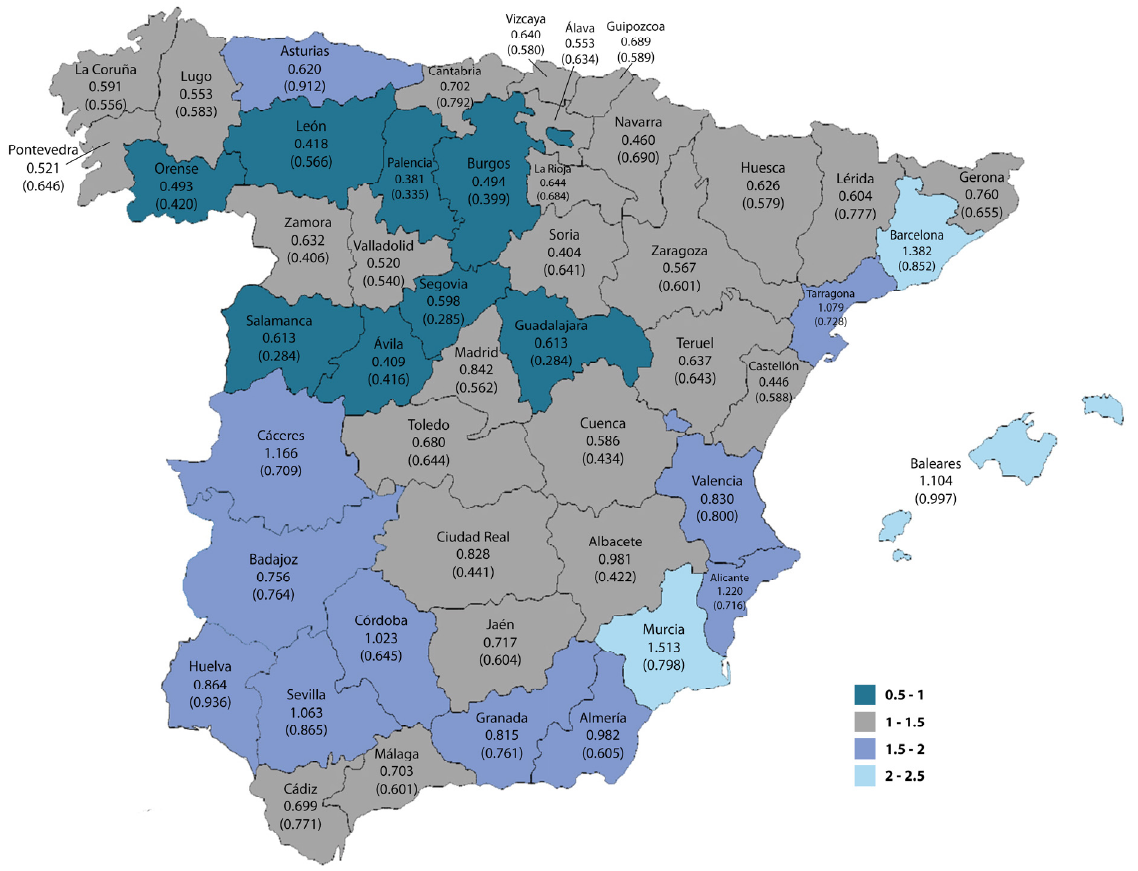
Figure 1. Average price of urban water cycle (in €/m 3 ) by province. Note: The figures without parentheses indicate the average price supply service. Figures in parentheses show the average price of sanitation and wastewater treatment. Source: Own elaboration from